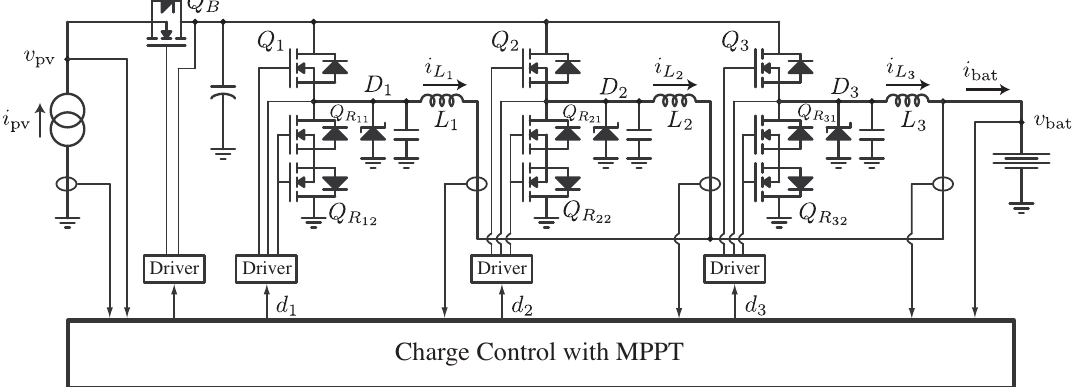
Figure 1. Photovoltaic (PV) battery charger using three parallelized step-down converters with synchronous rectification.